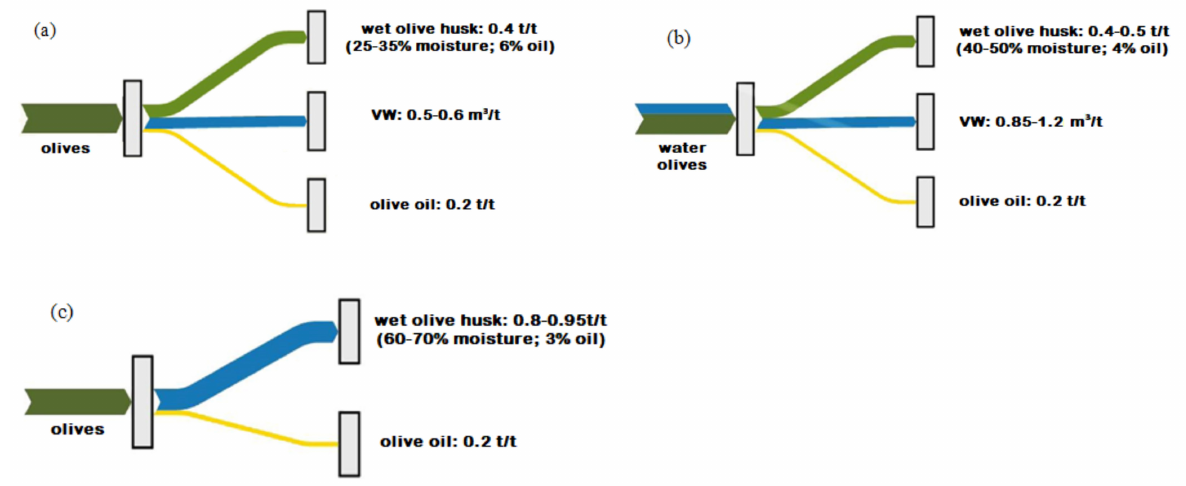
Figure 5. Material balance for the traditional ( a ) and for the two continuous three-phase ( b ) and two-phase ( c ) centrifugal systems.